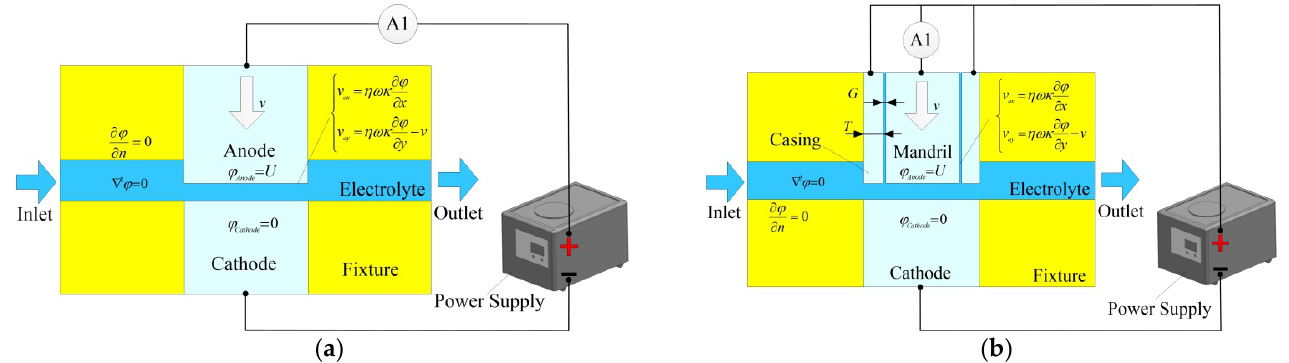
Figure 5. Schematics of models: ( a ) conventional constant voltage method; ( b ) casing-type anode measurement.